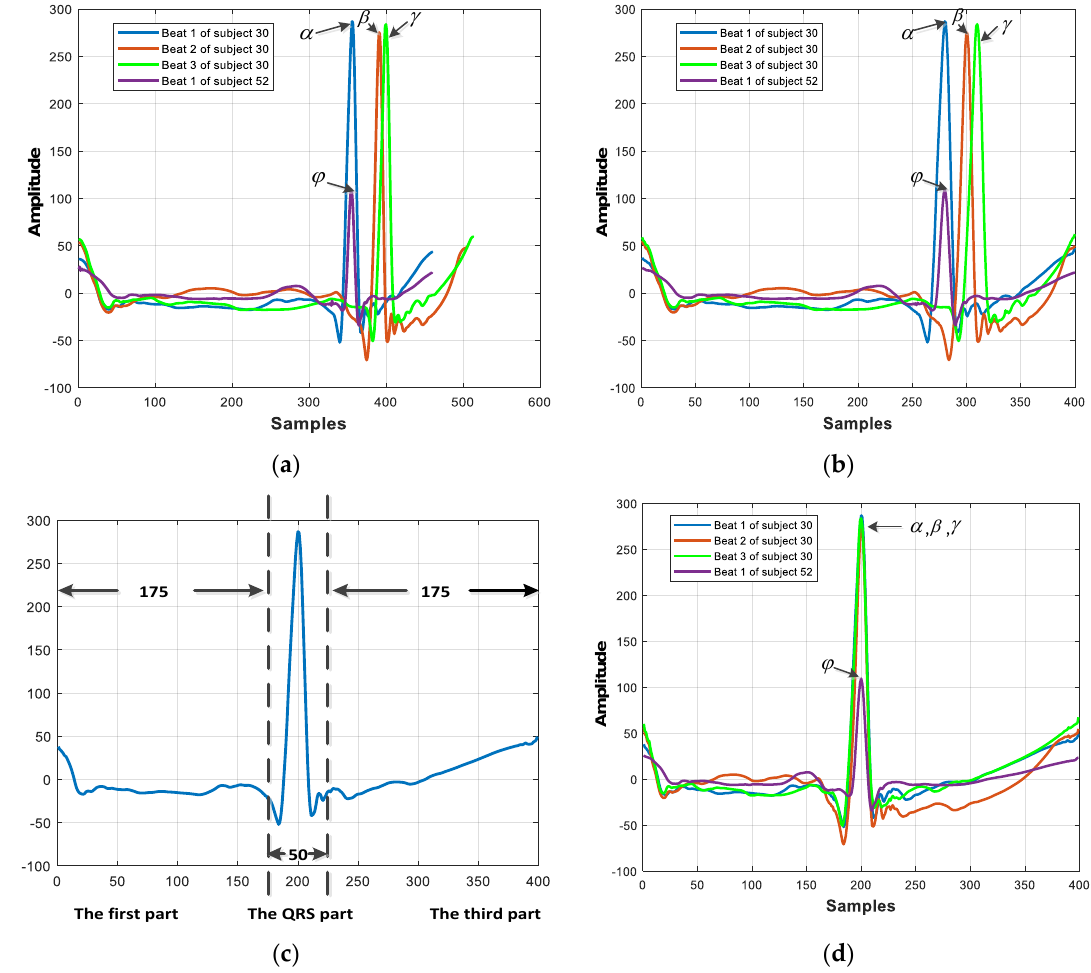
Figure 4. Comparison of heartbeats with different resampling manners. ( a ) Original heartbeats; ( b ) Heartbeats with direct resampling; ( c ) Normalization progress of the QRS-centered resampling; and ( d ) Heartbeats processed by the proposed method.